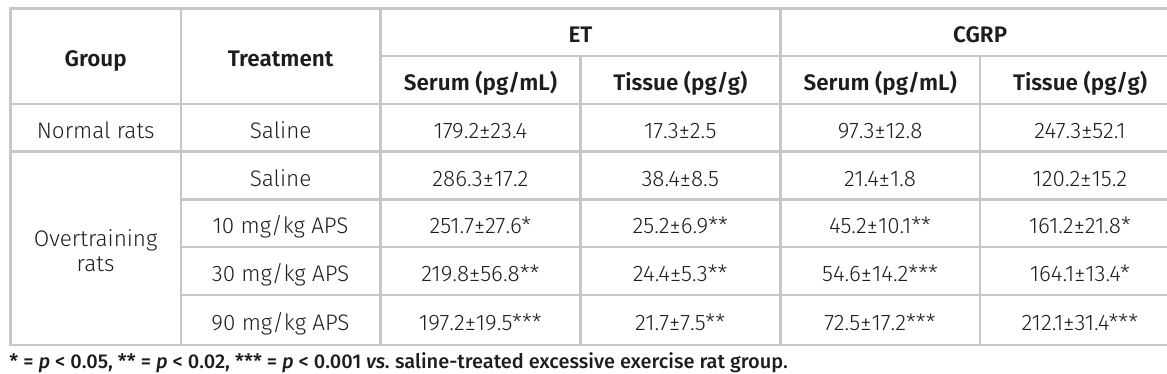
Table I. The contents of ET and CGRP in the rat serum and myocardium.